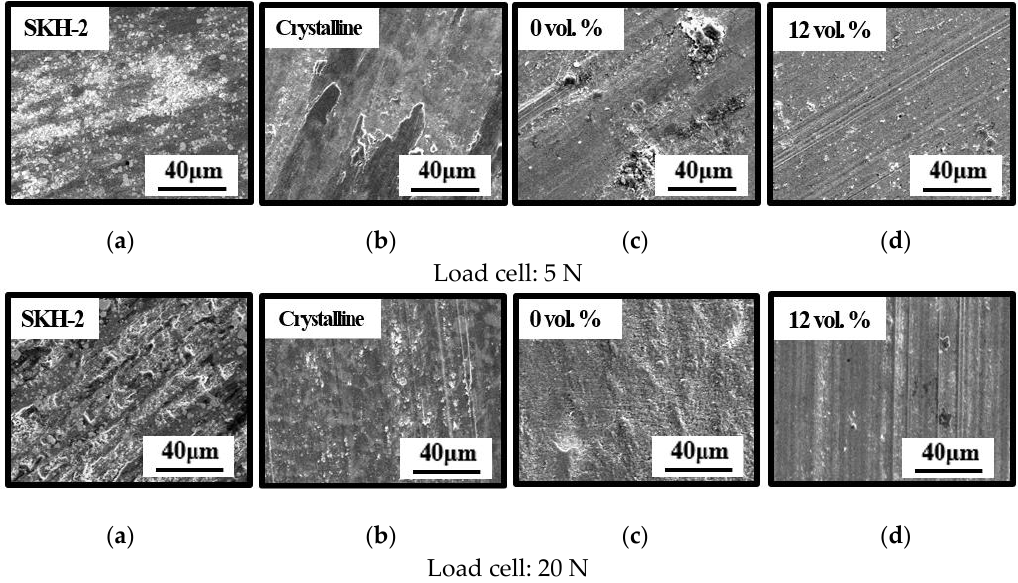
Figure 8. Mass loss of CNT/Ti 50 Cu 28 Ni 15 Sn 7 bulk metallic glass composites under different loads.